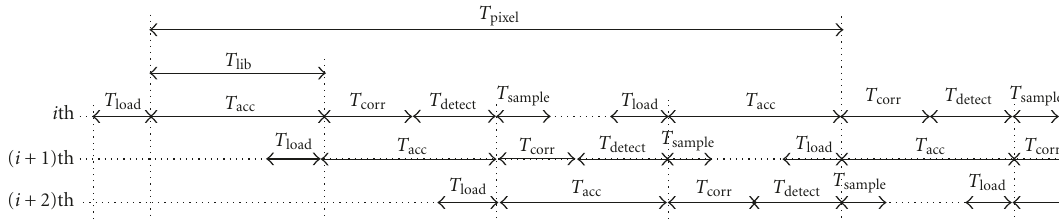
Figure 10: Execution time for a pixel ( T pixel ) in the pixel-based pipeline structure ( N LIB = 4).